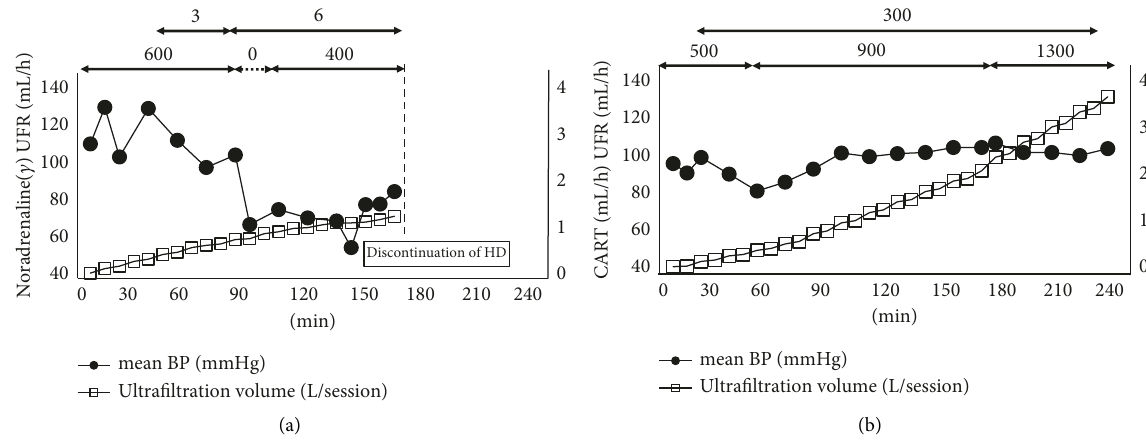
Figure 2: Differences in mean blood pressure and ultrafiltration volume during hemodialysis with or without CART. Abbreviations: BP, blood pressure; CART, cell-free and concentrated ascites reinfusion therapy; HD, hemodialysis; UFR, ultrafiltration rate. (a) HD without CART and (b) HD with